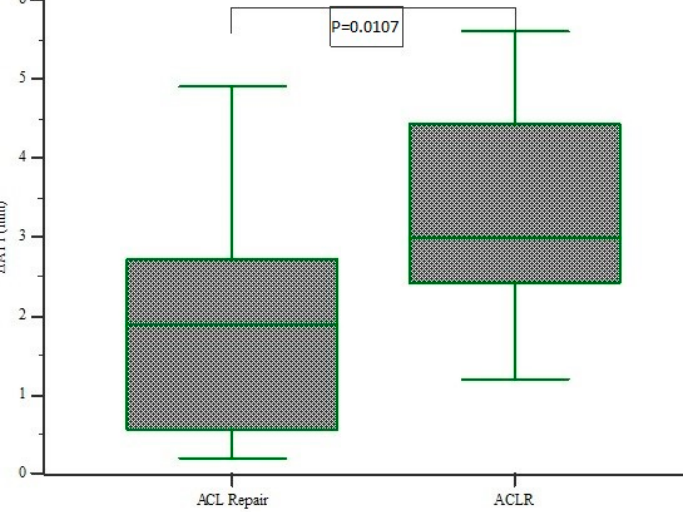
Figure 5. Box plot of assessments of side-to-side difference ( ∆ ATT) in ACL repair and ACLR group. It demonstrates a mean side-to-side difference 1.87 (range 0.2 to 4.9) mm in ACL repair significantly decreased compared to ACLR 3.36 (range 1.2 to 5.6 mm; p = 0.0107). The mean Lysholm score after 12 months was 89.2 (range: 57–100) in the internal bracing cohort and 89.9 (range: 67–100) in the ACLR group. No significant differences between ACL repair and ACLR were found for the Lysholm score ( p = 0.9793) (Figure 6). Additionally, no correlation was demonstrated between Lysholm scores and ATT for either surgical technique ( p >